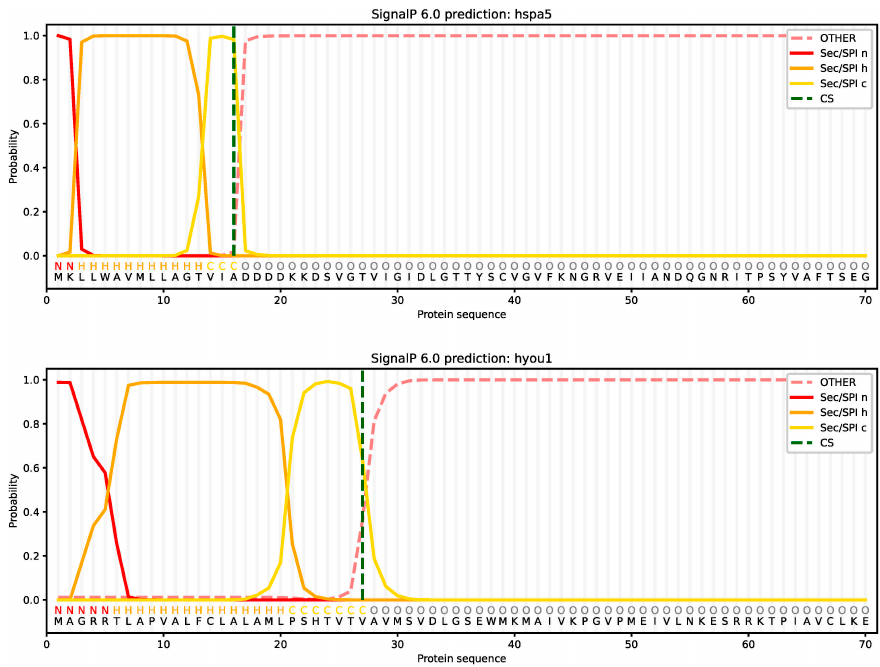
Figure 5. Signal peptide prediction analysis of the HSP70 proteins ( hspa5 and hyou1 ).